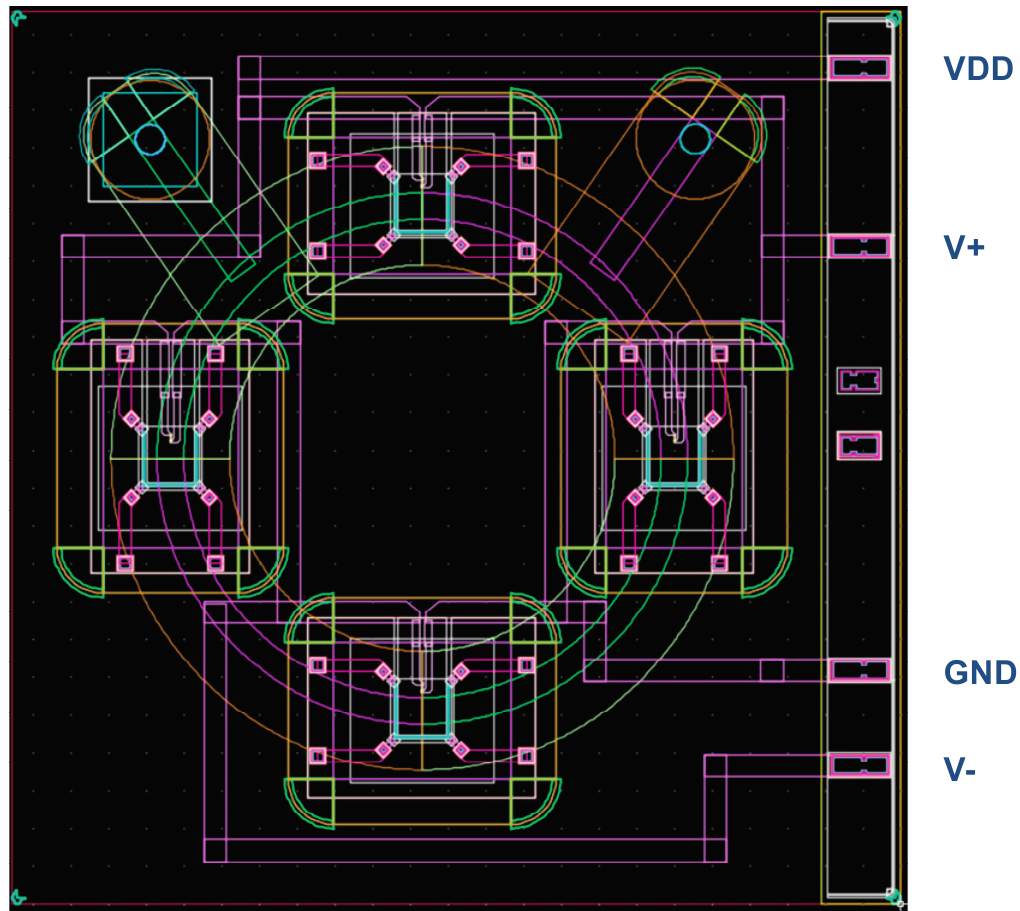
Figure 3. Actual physical layout of the structure consisting of: (1) top-glass canal (green quadrants in upper-left and bottom-right), (2) bottom-glass canal (lilac quadrants in bottom-left and upper right), (3) bulk micromachined silicon layer connecting upper and lower quadrants, intercepted by four flaps (light blue Π -shaped cuts in a 3.1 μ m silicon membrane) that are oriented in same direction in all cases and which contain a piezo-resistor centered on each of the membrane’s uncut side, (4) various conductors for powering the Wheatstone Bridge (VDD, GND) and differential outputs (V+, V −